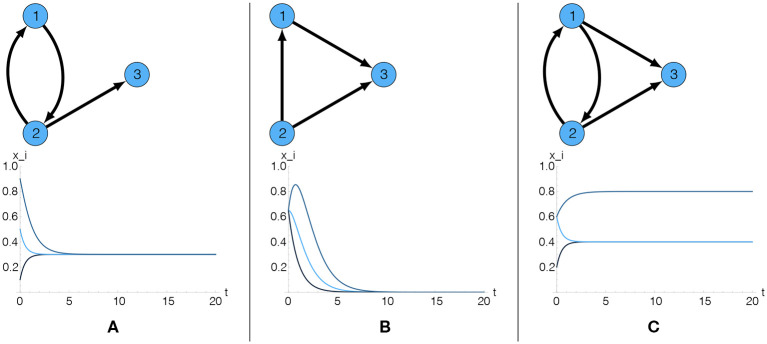
Impact of the adjacency matrix on the reputation Ri(t) of three agents. Only if cycles exist and agents are connected to these cycles, a non-trivial stationary reputation can be obtained. (A) The presence of one cycle guarantees a non-trivial stationary reputation, identical for all agents. (B) The absence of cycles results in a trivial stationary reputation for all agents. (C) The presence of a cycle guarantees non-trivial stationary reputations. Furthermore, two different stationary values appear when agent 3 has 2 incoming links to boost its reputation.